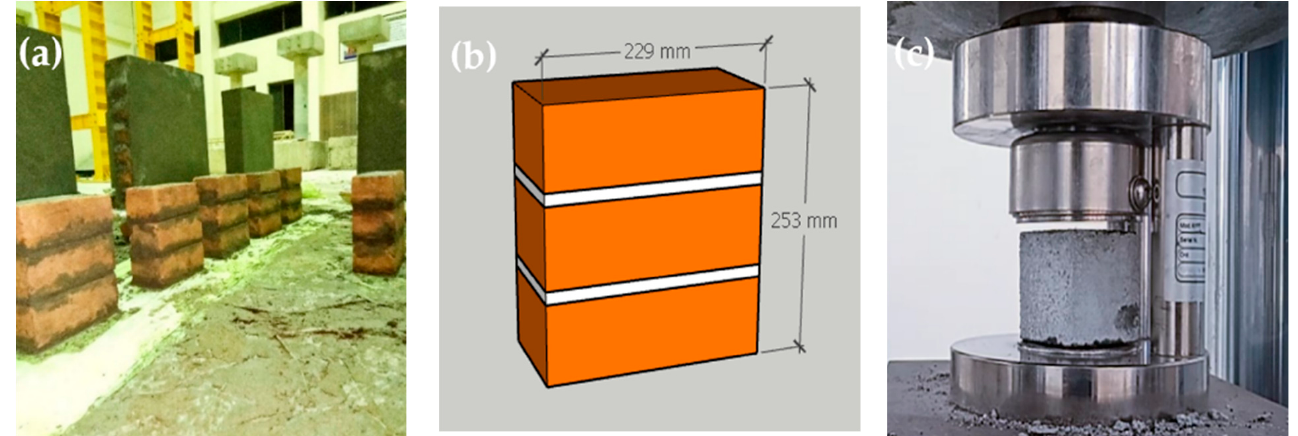
Figure 1. Masonry prism and mortar cubes. ( a ) Prism specimens during curing; ( b ) Prism dimensions; ( c ) Mortar cube compression.